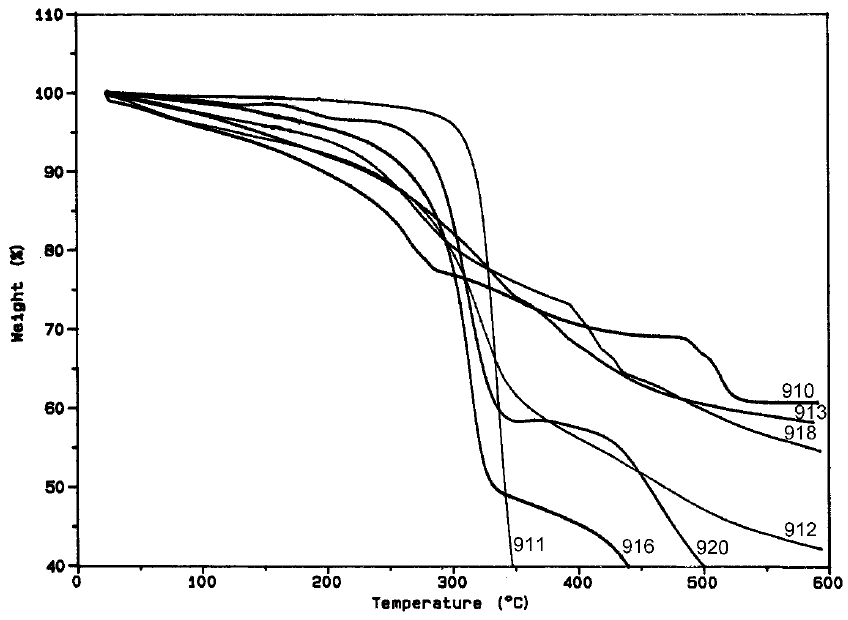
Fig. 3 TGA diagram of products with PVAc (s.911: PVAc; s.910: PVAc+TIP; s.912: PVAc+TIP+MPTS; s.913: PVAc+TIP+MPTS; s.918: PVAc+TIP+VTES; s.920: PVAc+TIP+OTES) and with PMMA (s.916: